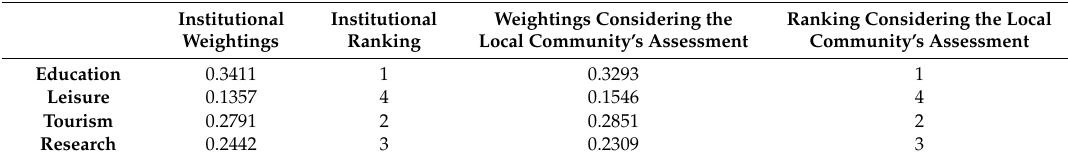
Table 5. Weightings and institutional ranking; weightings and ranking considering the local community’s assessments of the objectives relative to land use.